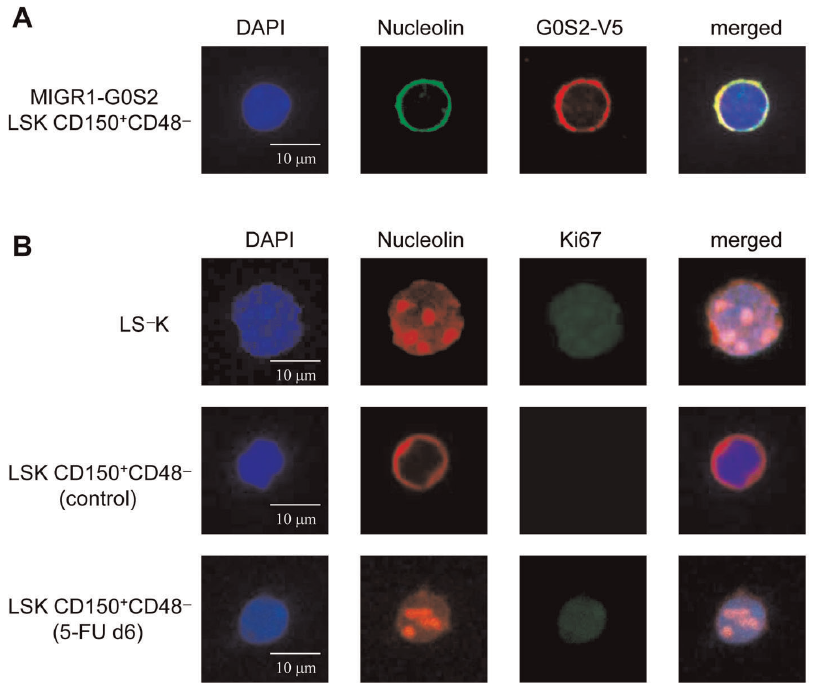
Figure 7. Quiescent HSCs exhibit cytosolic sequestration of nucleolin. (A) Nucleolin colocalizes with the overexpressed G0S2 protein in LSK CD150 + CD48 2 cells purified from mice transplanted with BM cells transduced with the MIGR1-G0S2 V5-tagged retrovirus. (B) Expression of nucleolin and Ki67 was determined in wild-type LS 2 K (proliferative progenitors), LSK CD150 + CD48 2 cells purified from wild-type mice (dormant HSCs), and LSK CD150 + CD48 2 cells purified from wild-type mice injected 6 days earlier with a single dose of 5-FU (proliferative HSCs). Images of DAPI, nucleolin, and Ki67 staining are shown for a representative cell. The data represent two independent experiments.